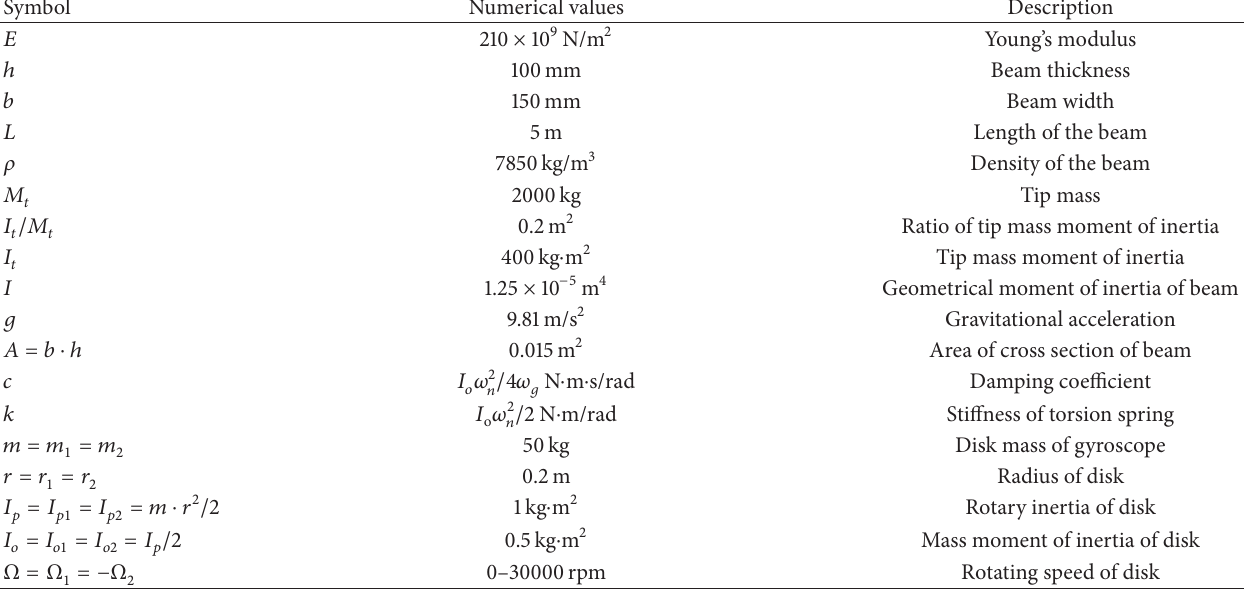
Table 1: Physical properties of the system.